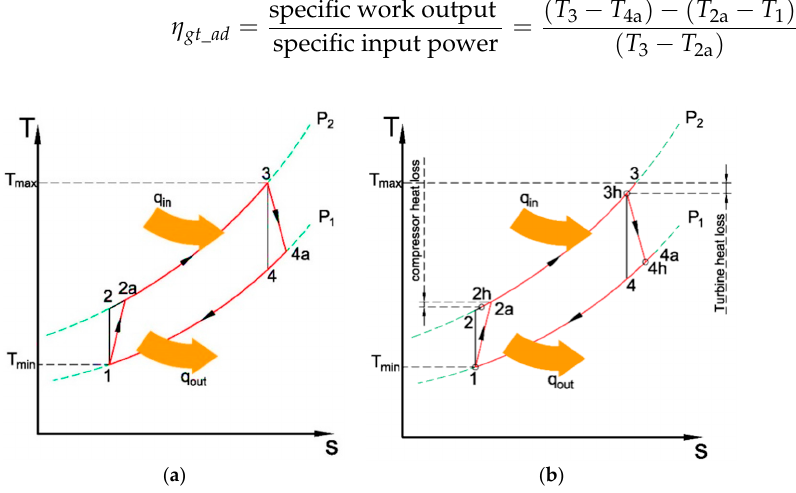
Figure 6. T-S diagram for gas turbine operating on an ( a ) adiabatic cycle and ( b ) non-adiabatic cycle.